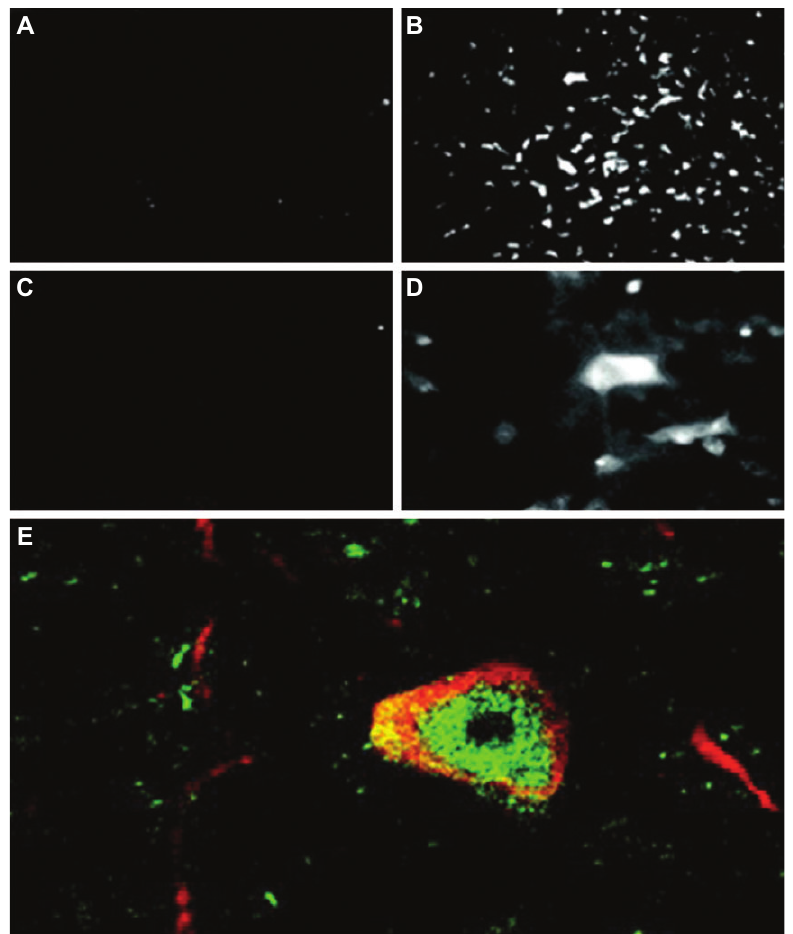
Figure 10 ORMOSIL nanoparticle transfection in the substantia nigra per compacta. (A) DNA-free ORMOSIL injection showing no sub- stantial immunostaining for enhanced GFP (EGFP). (B – E) Injection of ORMOSIL plasmid DNA encoding the GFP complex into the substantia nigra per compacta. (B) Multiple cells with typical dopaminergic neuron morphology are immunostained positive for EGFP. (C) No immuno- staining is observed without primary anti-EGFP Ab. (D) EGFP immunostaining of neuron-shaped cells (higher magnifi cation). (E) Transfected EGFP (green) is expressed in a tyrosine hydroxylase-immunopositive (red) dopaminergic neuron. From Ref. [154] ; reproduced with kind © permission 2012 from National Academy of Sciences,